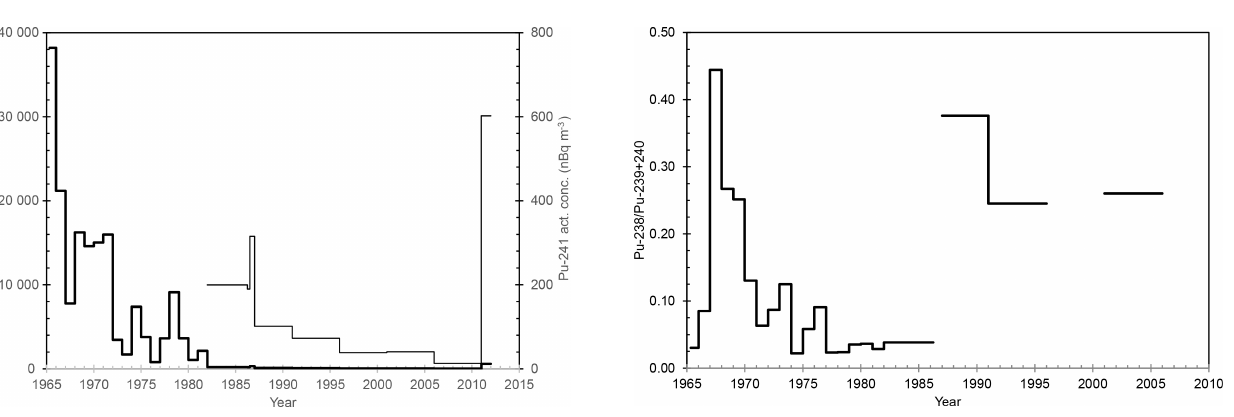
Figure 2. The activity concentration of 241 Pu (nBqm − 3 ) in the sur- face air of Rovaniemi (thick line for 1965–2011 with the left vertical scale; thin line for 1982–2011 with the right vertical scale). Values below the detection limit have been depicted as half the MDA value (Table 1).